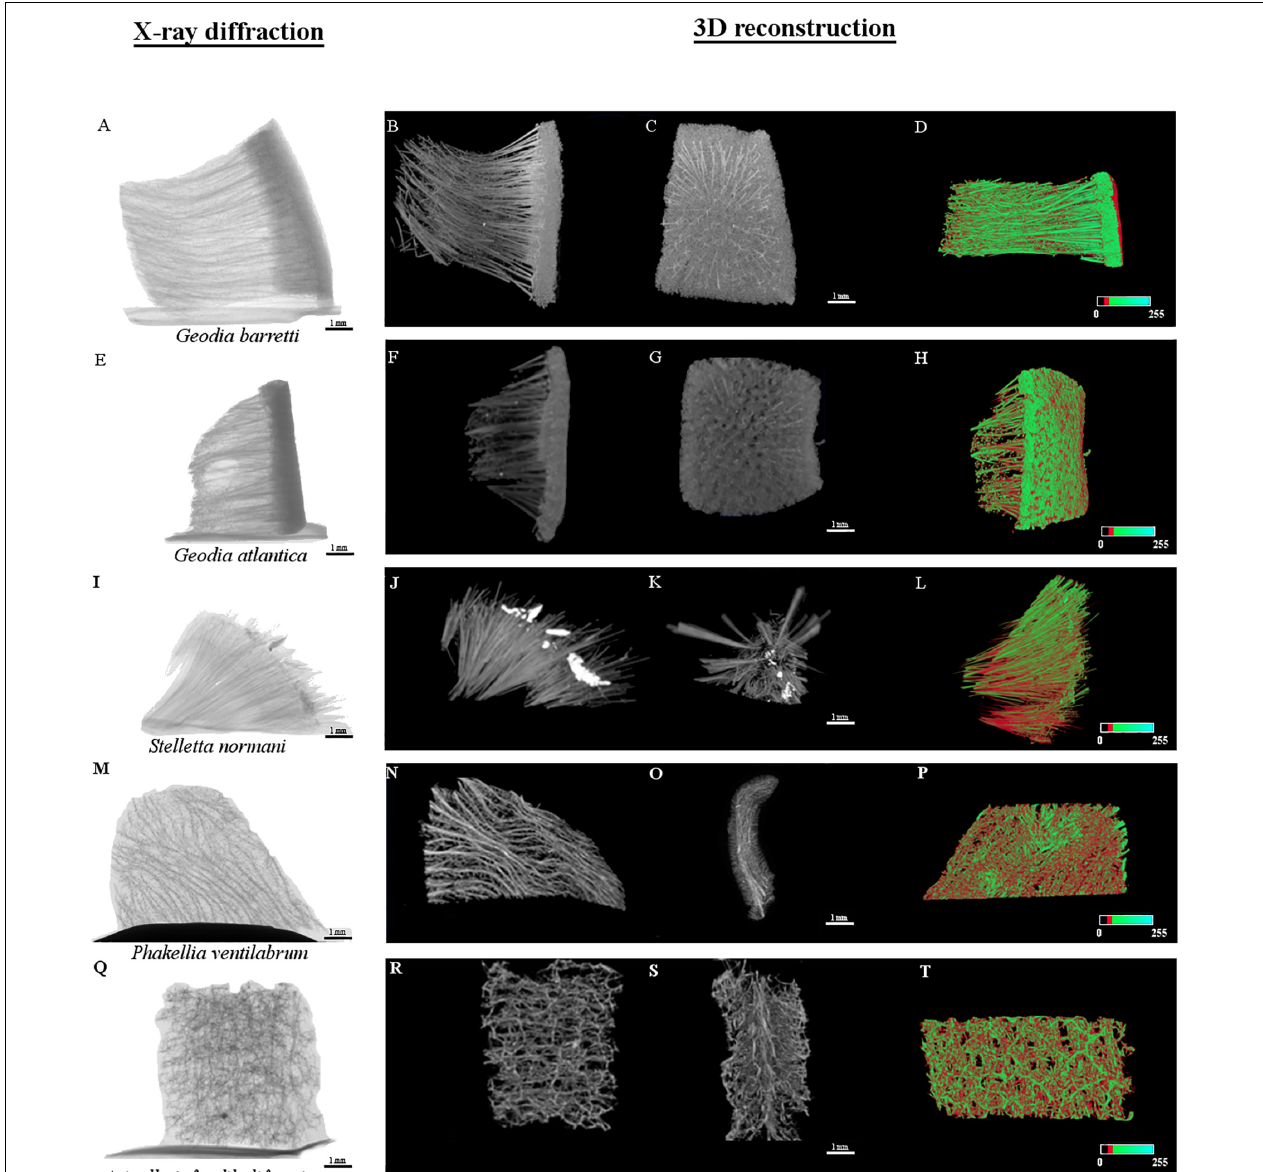
FIGURE 6 | Micro-CT micrographs of the internal microstructure of Geodia barretti (Gb), Geodia atlantica (Ga), Stelletta normani (Sn), Phakellia ventilabrum (Pv), and Axinella infundibuliformis (Ai). The X-ray diffraction images of the internal microstructure acquired for the five specimens (A,E,I,M,Q) respectively, following the order mentioned above. The other series of images represent the three-dimensional (3D) reconstruction. The gray levels micrographs represent two X-ray attenuation in different virtual position (B,C,F,G,J,K,N,O,R,S) . The color micrographs represent the distribution of organic (red) and inorganic (green) matter (D,H,L,P,T)